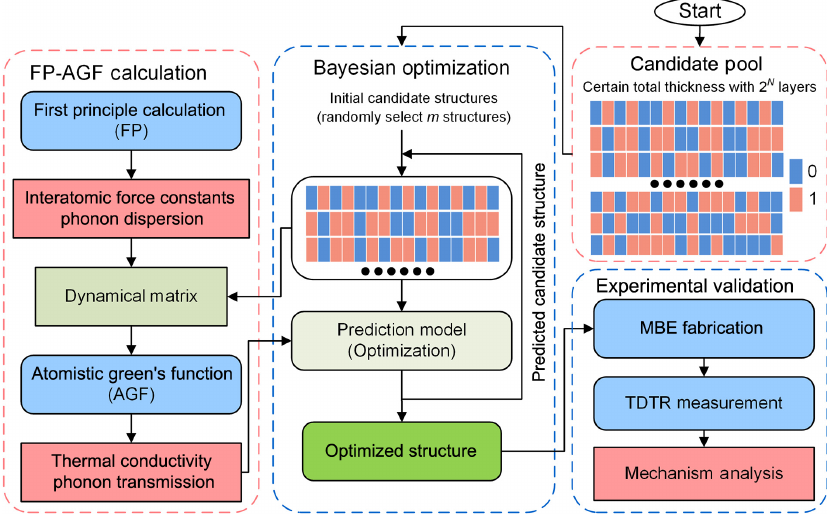
FIG. 1. Flowchart of the optimal control for coherent phonon heat conduction. Structural optimization for minimum thermal conductivity is achieved by alternately coupling Bayesian optimization and first-principles (FP) atomistic Green ’ s function (AGF) calculation, fabrication by molecular beam epitaxy (MBE), and measurements by the time-domain thermoreflectance (TDTR)